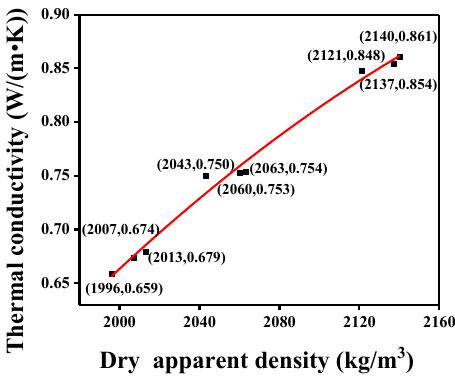
Figure 14. Fitted curve between thermal conductivity and dry apparent density